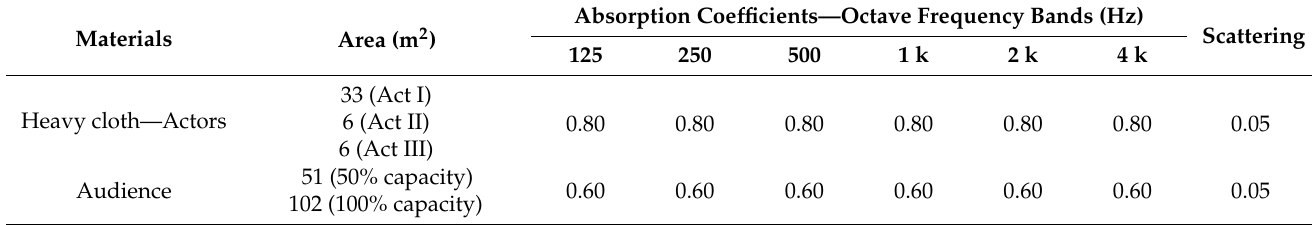
Table 2. Surface, absorption and scattering coefficients of the additional materials considered during the acoustic simulations.